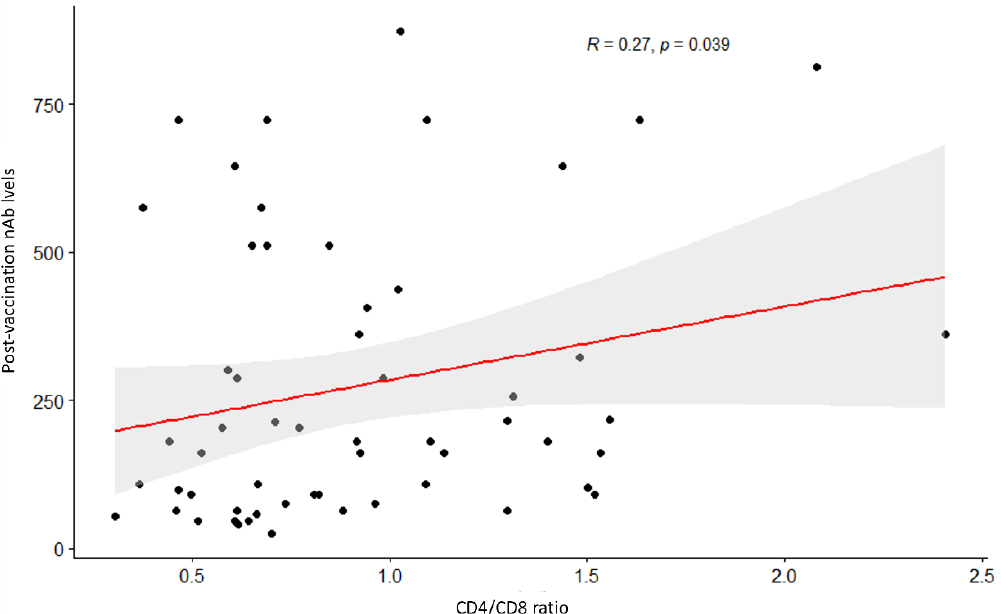
Figure 2. Scatterplot between CD4/CD8 ratio and post-vaccination neutralization antibody titers. p value (i.e., 0.039) for the Spearman’s test indicates a significant relationship at a 5% significance level.